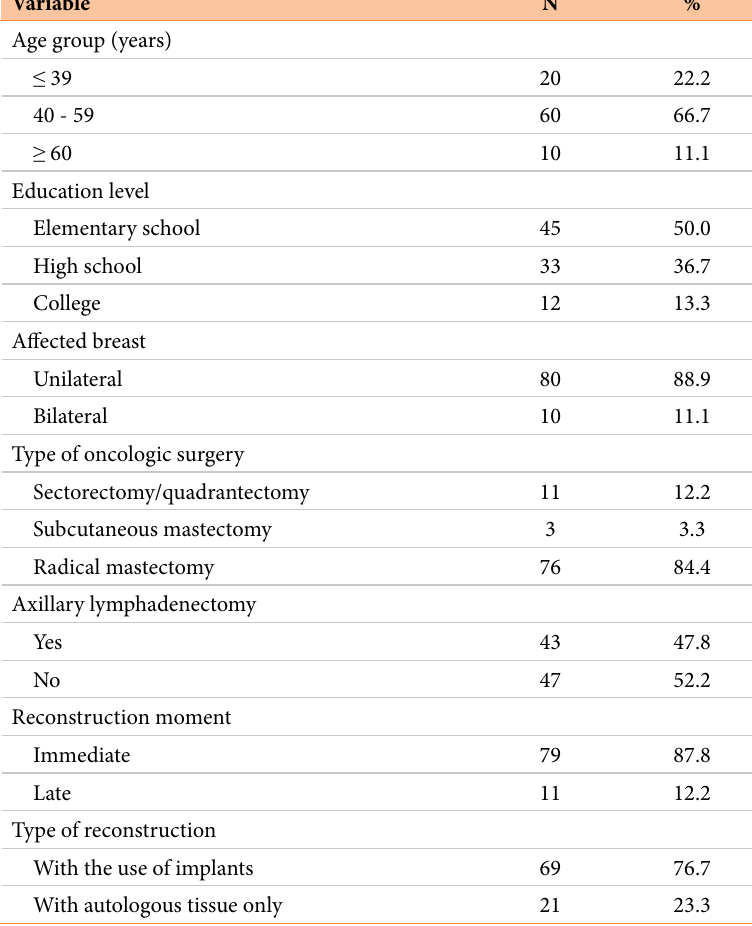
Table 1 – Patients’ main clinical and demographic